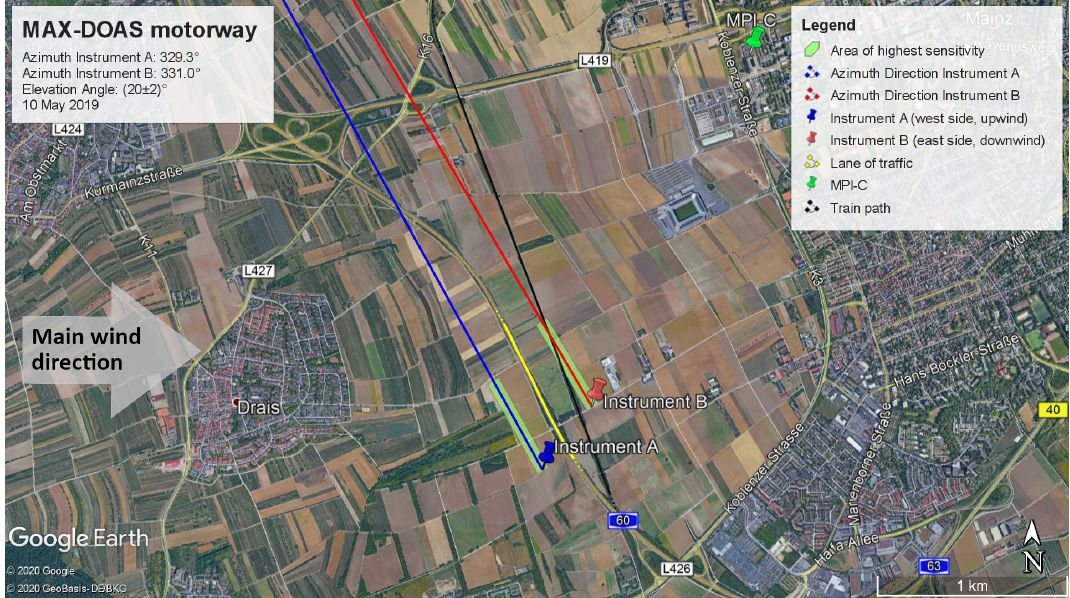
Figure 1. Alignment of the two Tube MAX-DOAS instruments on the measurement day, 10 May 2019. The instruments are located on both sides of the A60 motorway in Mainz, Germany, with a viewing direction parallel to the lane of traffic. The area between both instruments encloses the motorway and the railway track. Our measurements have highest sensitivity within the shaded green area. On the measurement day, continuous wind from westerly directions was present. Created with © Google Earth Pro (2018).